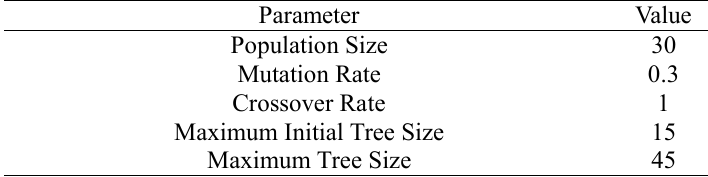
GP adjusted value for computer program while training and test.